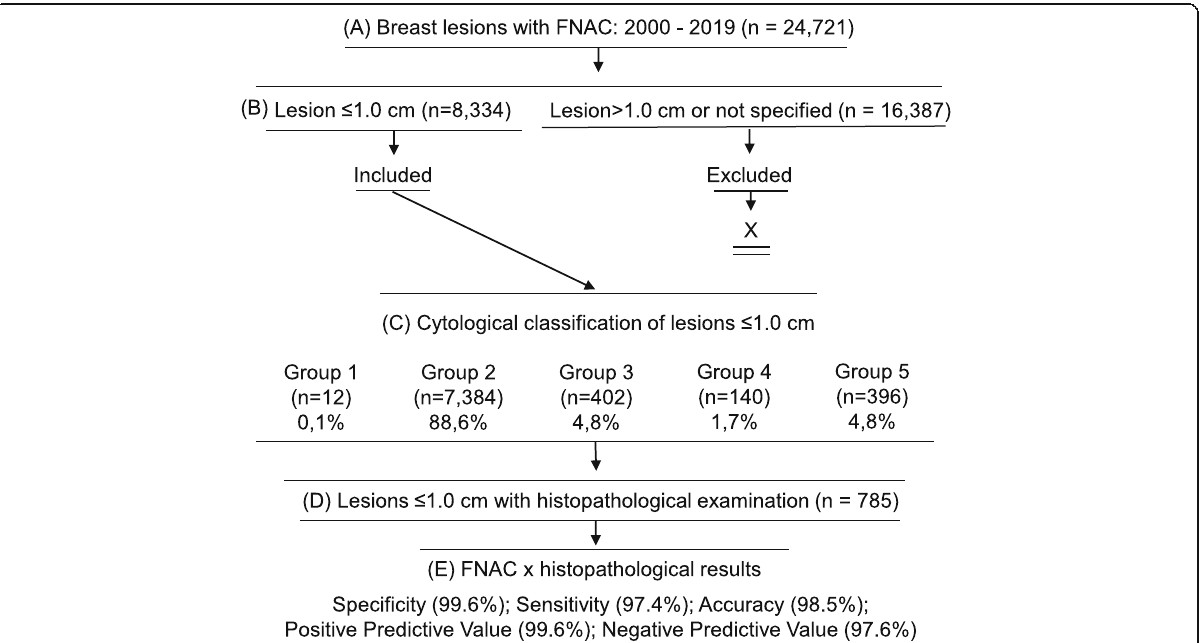
Fig. 1 Flowchart of the study design. a Retrospective assessment of breast lesions subjected to FNAC between January 1, 2000 and December 31, 2019. b Lesions ≤ 1.0cm were included in the study, and those measuring >1.0cm were excluded. c Review of FNAC reports and classification of the lesions into one of five categories: group 1, insufficient or inadequate; group 2, benign; group 3, atypical; group 4, suspicious of malignancy; and group 5, malignant. d Review of histopathological reports to identify a surgical specimen corresponding to the sampled lesion and cytohistological correlation. e Results obtained from the cytohistological correlation between benign and malignant lesions. Abbreviations: FNAC, fine-needle aspiration